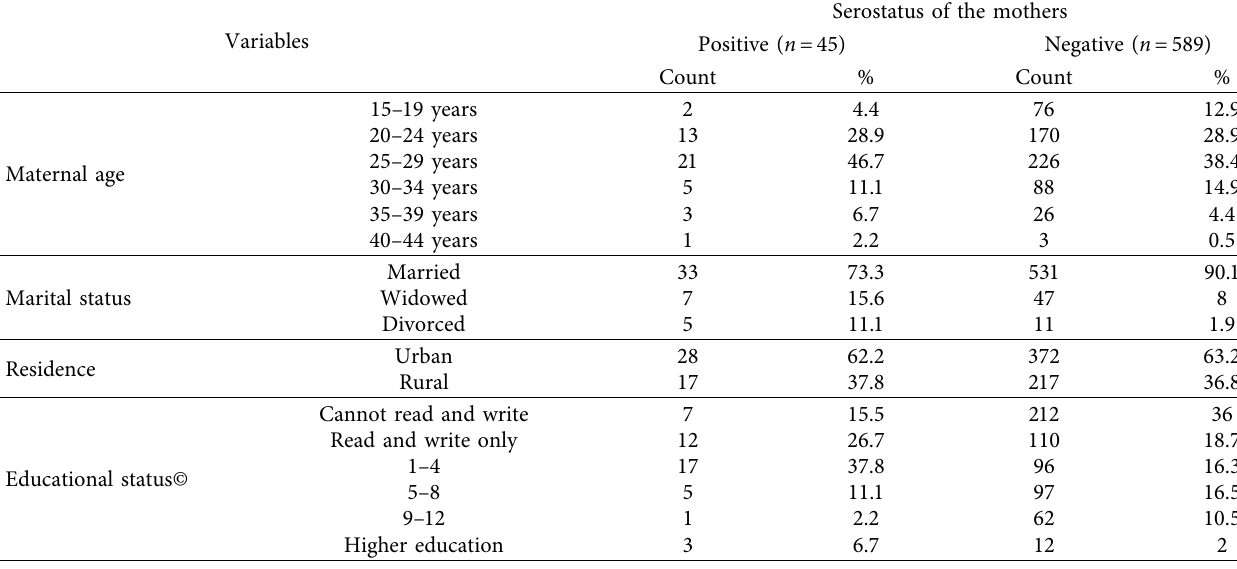
Table 1: HIV serostatus by maternal sociodemographic characteristics among pregnant mothers on ANC follow-up at